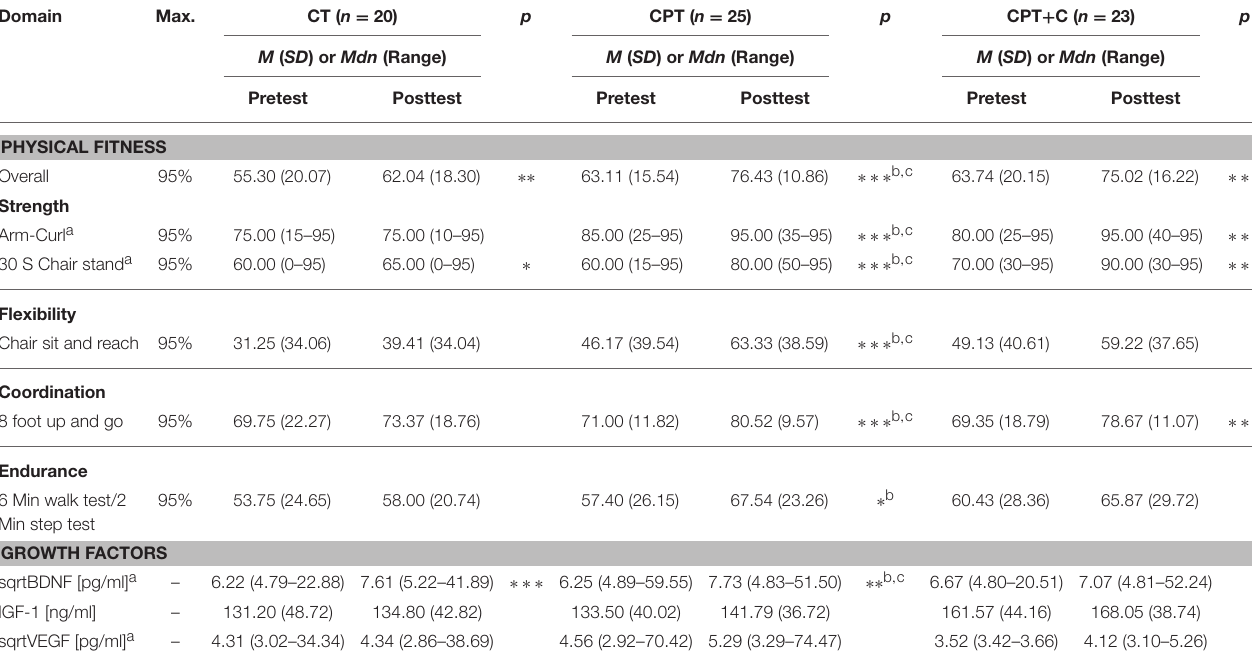
TABLE 3 | Secondary outcomes of the training groups at pre- and post-test. Domain